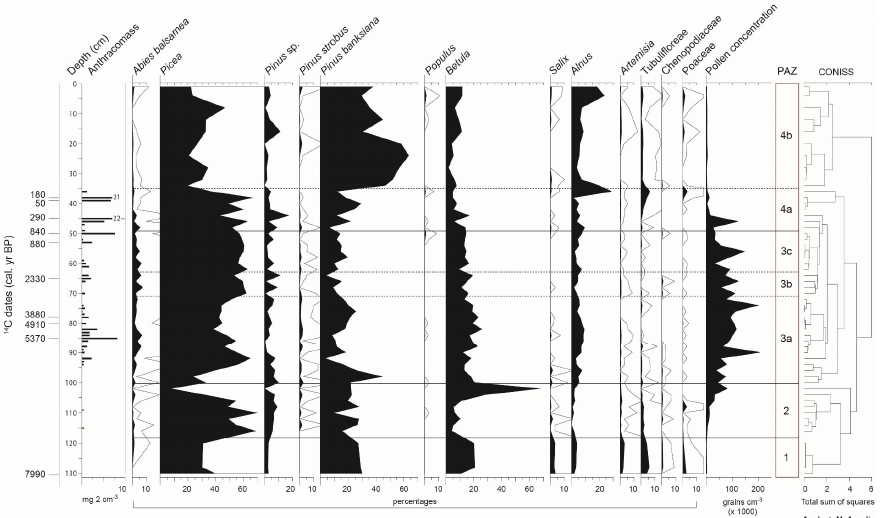
Figure 6. Pollen diagram (percentages; selected taxa) and charcoal content (mg ∙ 2 cm ‐ 3 ) of the sedimentary core collected at Aspen peatland. Open curves show a 10× exaggeration.